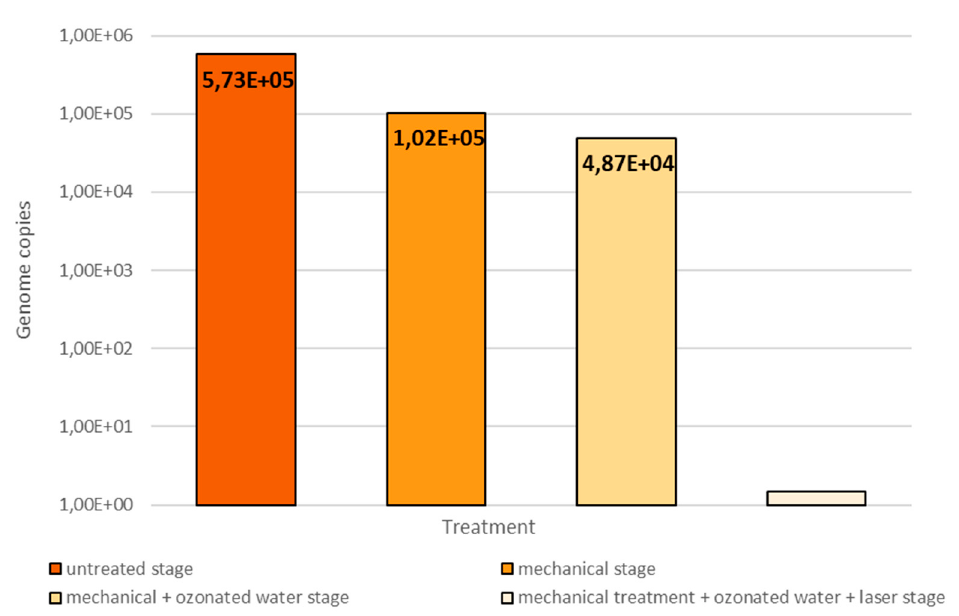
Figure 5. qPCR test values of E. faecalis for the four protocol stages.